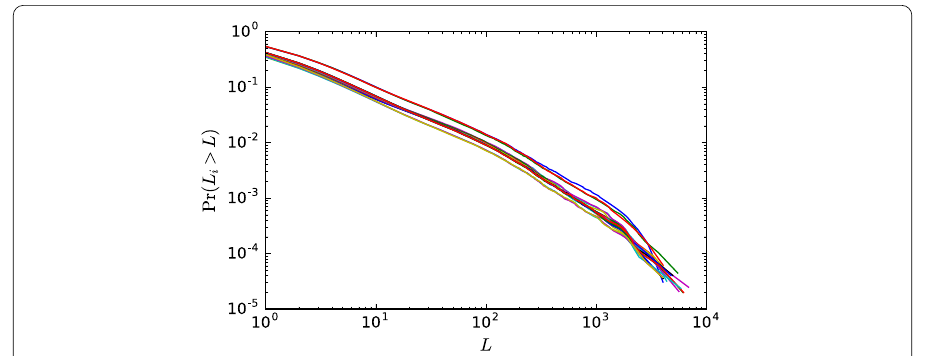
Figure 22 Annual firm size cumulative distributions for Finland between 1988 and 2008